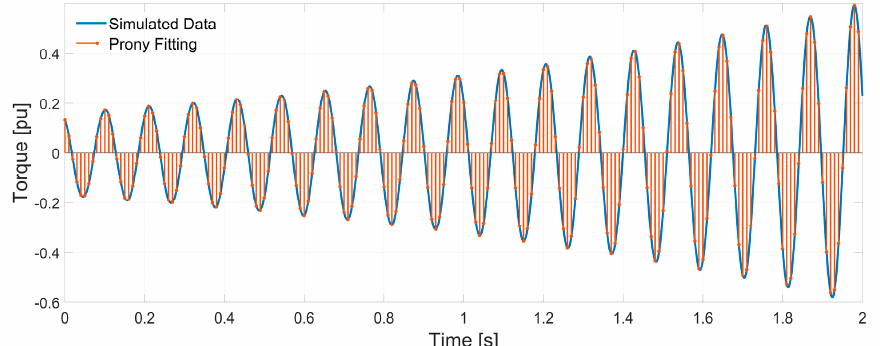
Figure 16. TG shaft-line torque in configuration CA (simulation results).